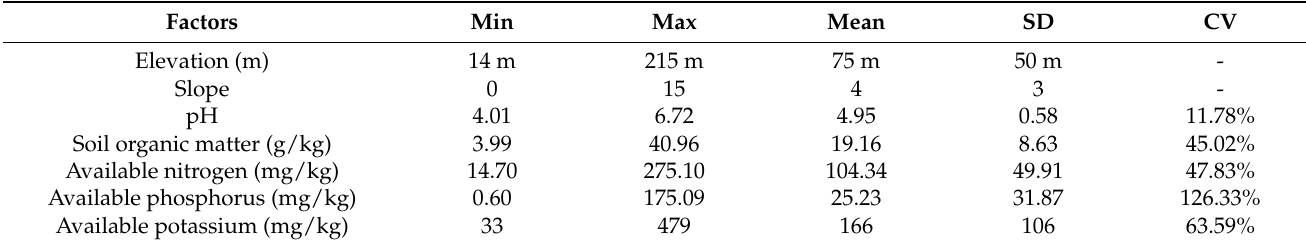
Table 1. Statistical table of investigation factors in tea plantations.